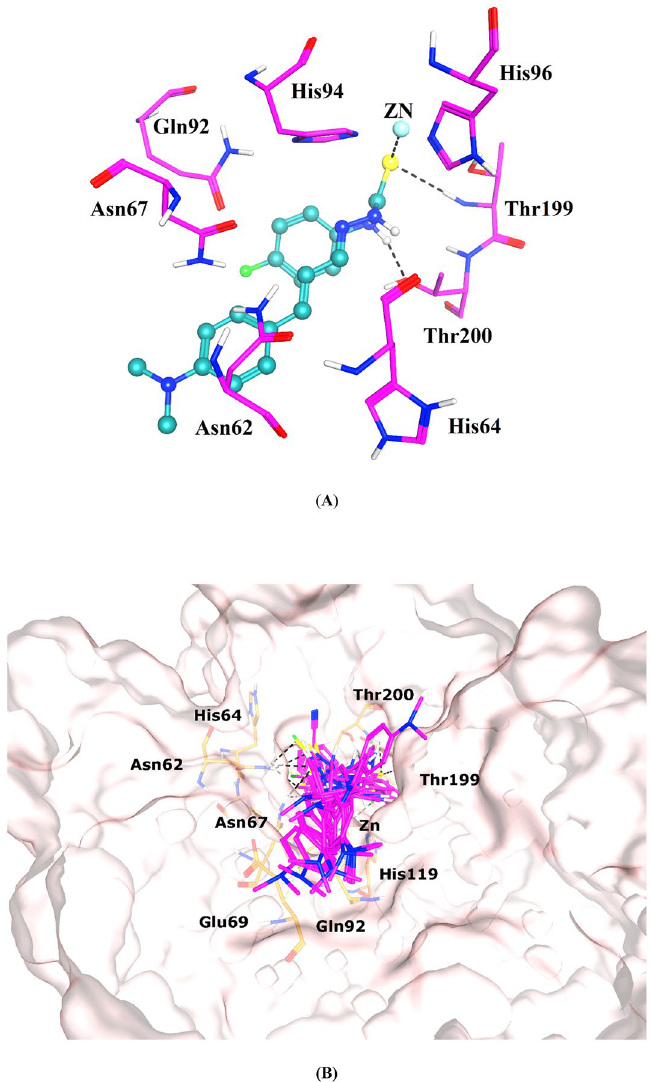
Figure 2. ( A ) The binding mode of the most active compound ( 3n ) is shown. The ligand is depicted in cyan ball and stick model, interacting residues are demonstrated in magenta stick model, and hydrogen bonds are presented in black dotted lines. ( B ) The docked conformations of all the active ligands are displayed in the active site of CA-II. Ligands are presented in magenta color, the active site residues are shown in orange stick, H-bonds are depicted in black dotted lines. The protein in shown in surface